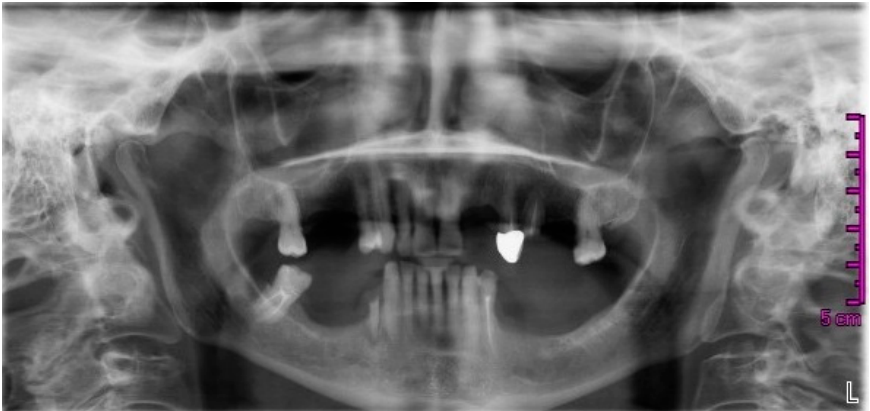
Figure 1. Orthopantomography dated November 2013.